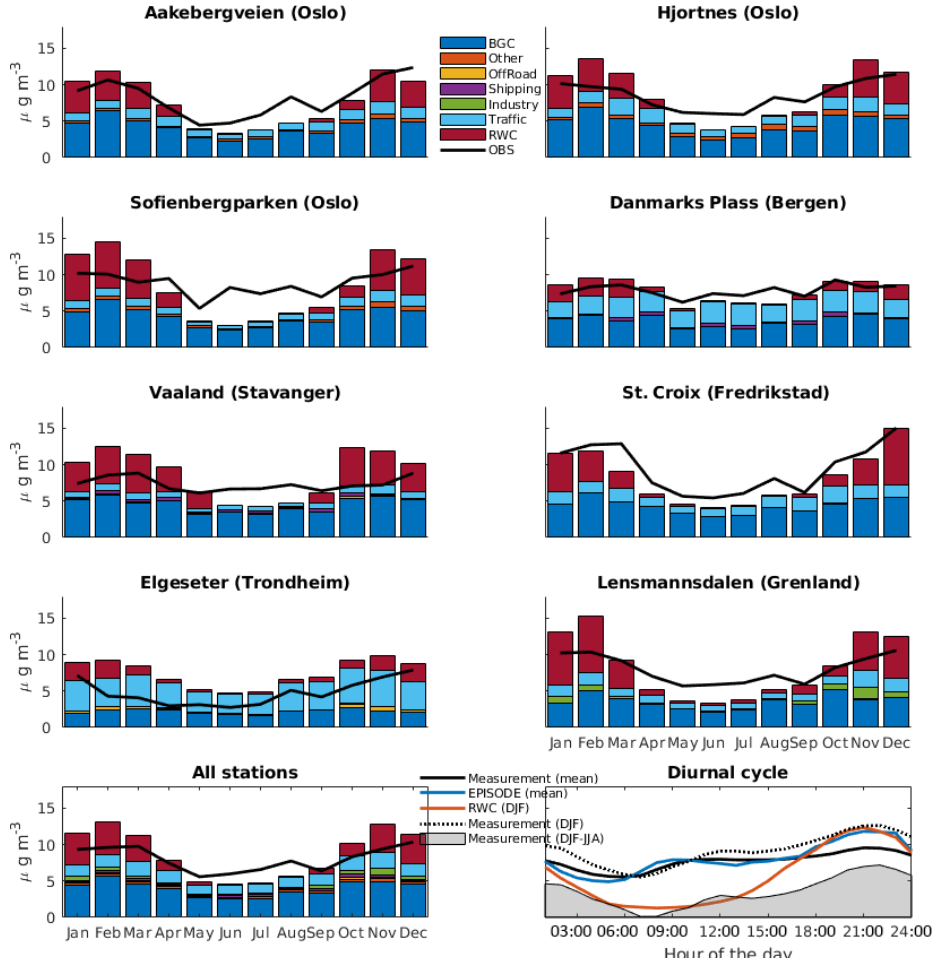
Figure 7. Average concentration of PM 2 . 5 averaged at air quality stations and as a total annual average. Bottom right: the annual average diurnal variability concentration as indicated by measurements (black) and the model (blue). The orange line shows the contribution from wood burning and the shaded area is calculated as the measurement hourly average in winter (NDJF) – summer (JJA). The bars show the monthly average concentration by sector and the black line the measurement monthly